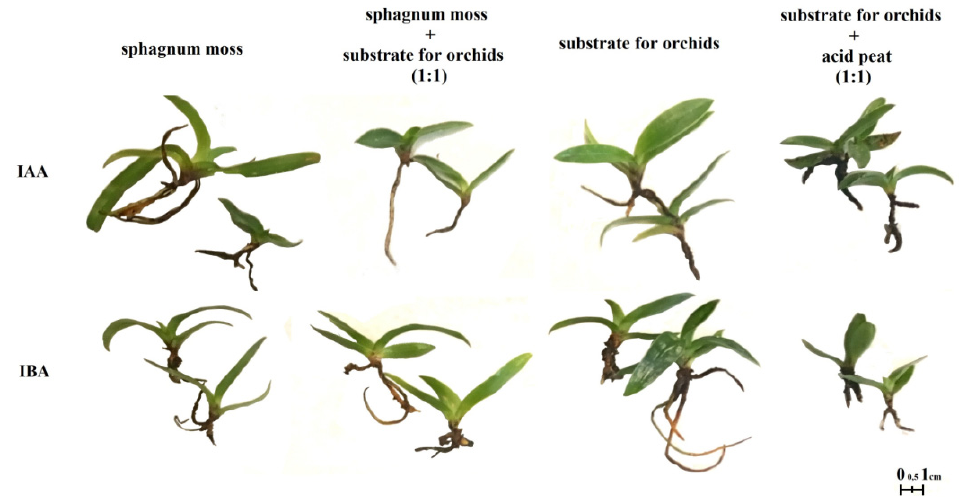
Figure 2. The influence of NAA, IAA and IBA auxins on in vitro rooting and morphological features of Paphiopedilum insigne plantlets.